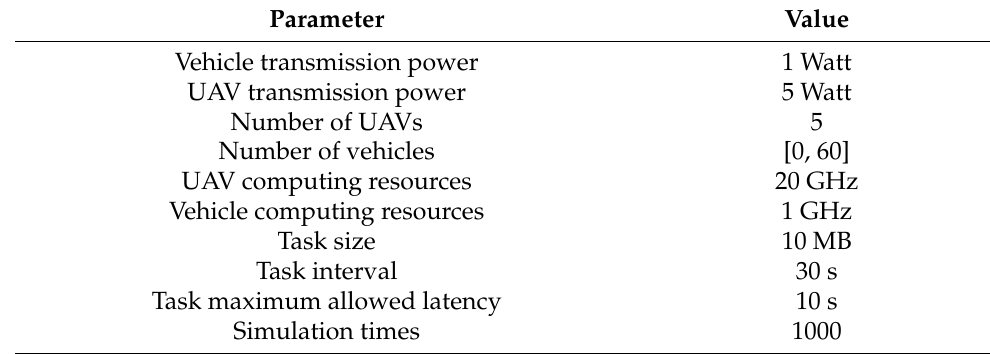
Table 1. Simulation parameters.